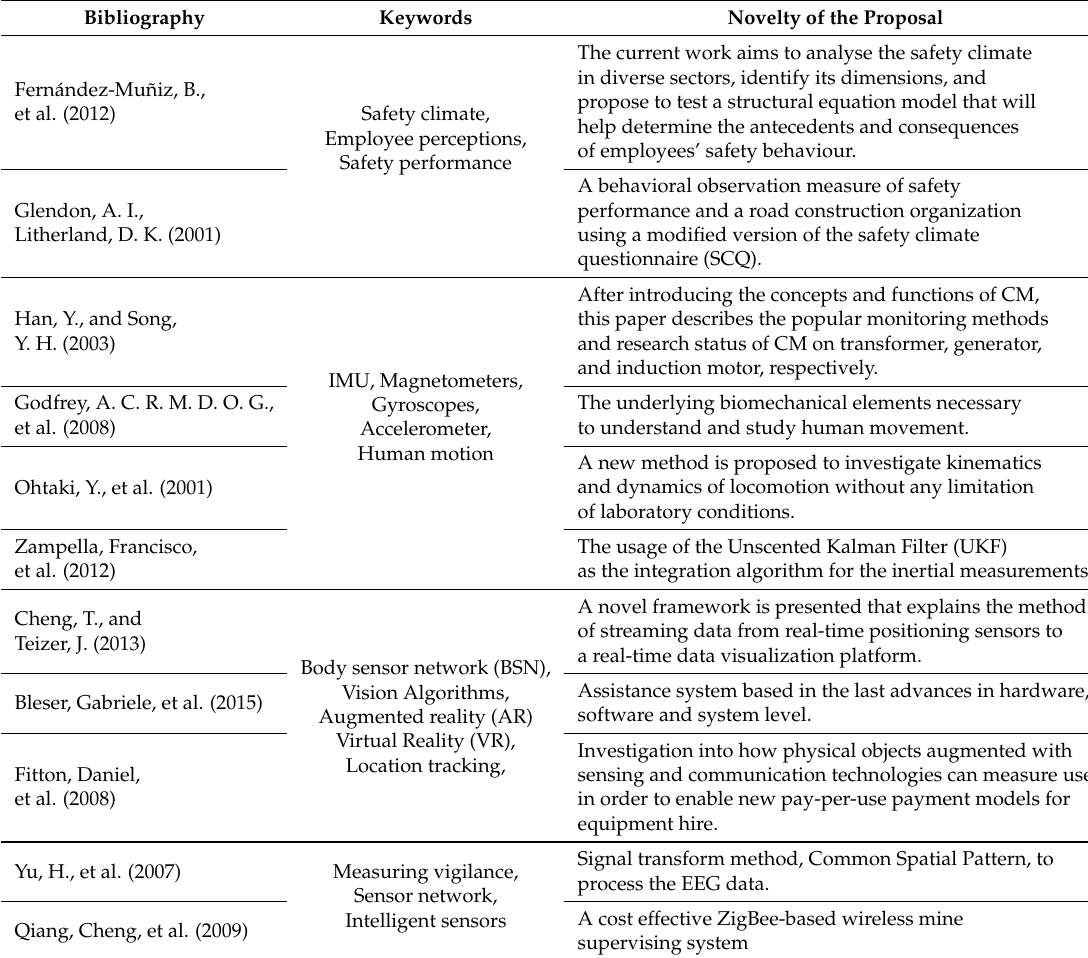
Table 3. Proposals related to safety environment and motion